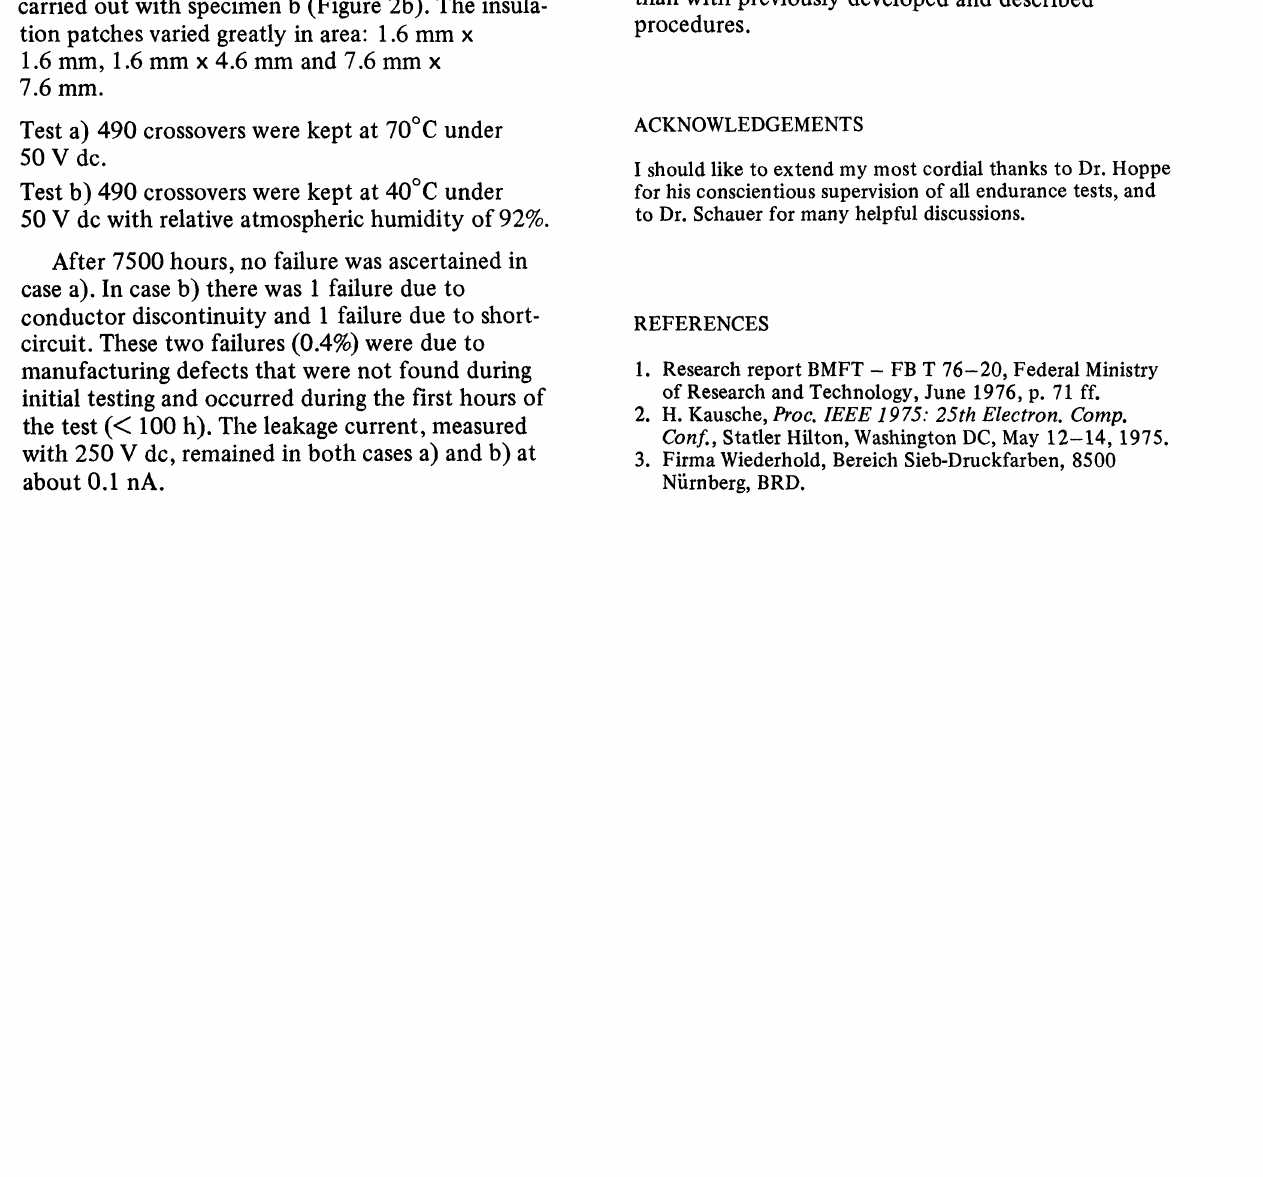
FIGURE 4 Dependence of capacitance from the crossover